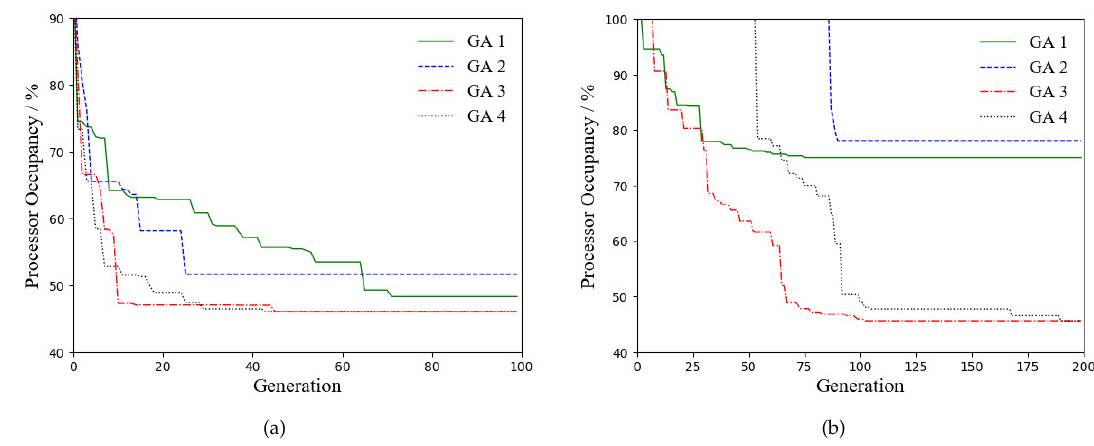
Figure 10. Evolution of minimum processor occupancy in optimization experiments. ( a ) Experiment 1. ( b ) Experiment